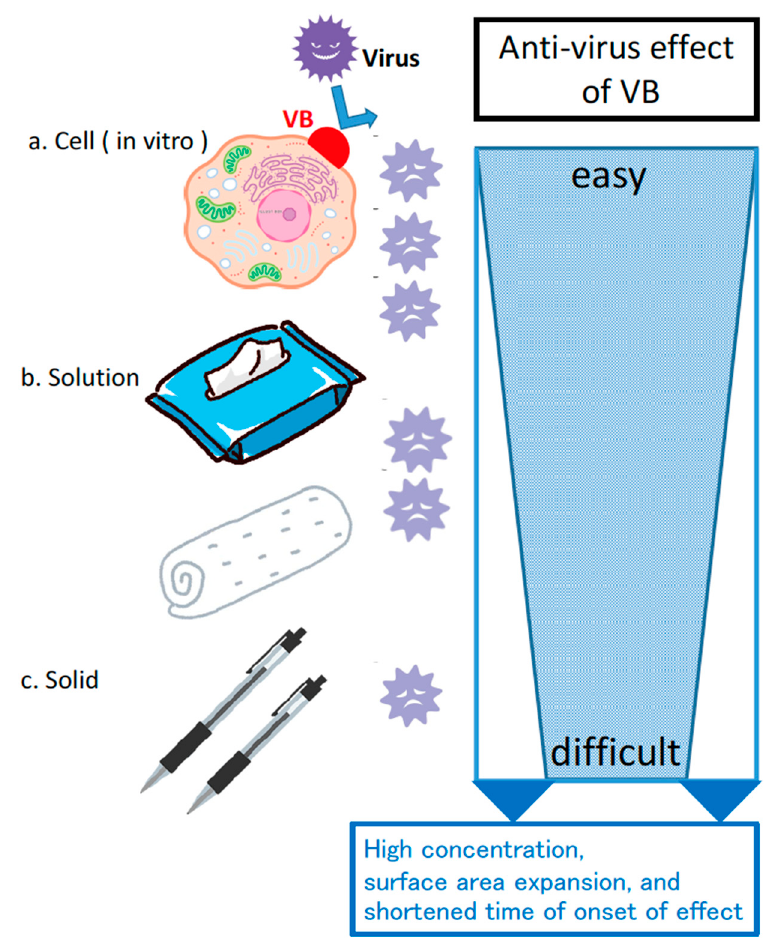
Figure 6. Effects of VB on the applicable materials. Figure 6. E ff ects of VB on the applicable